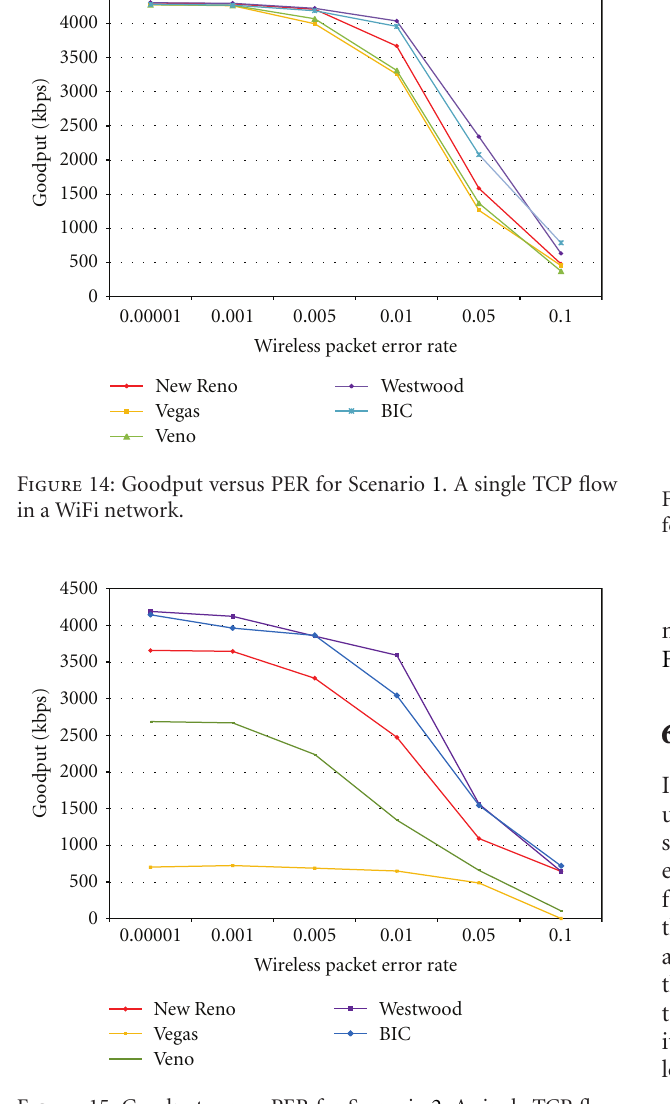
Figure 15: Goodput versus PER for Scenario 2. A single TCP flow in a heterogeneous WiFi network.